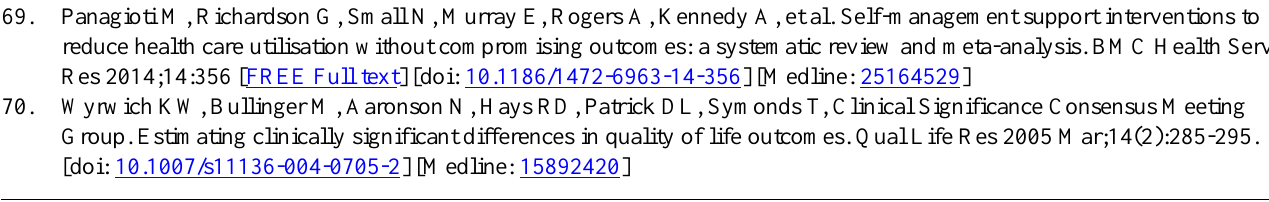
ANCOVA: analysis of covariance CSE: Cardiac Self-Efficacy scale CVD: cardiovascular disease EQ VAS: EQ-5D-5L Visual Analog